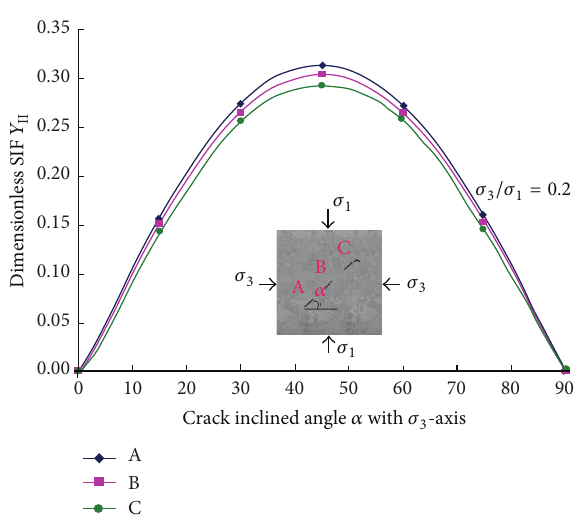
Figure 8: 𝑌 ΙΙ at points A, B, and C from Abaqus.